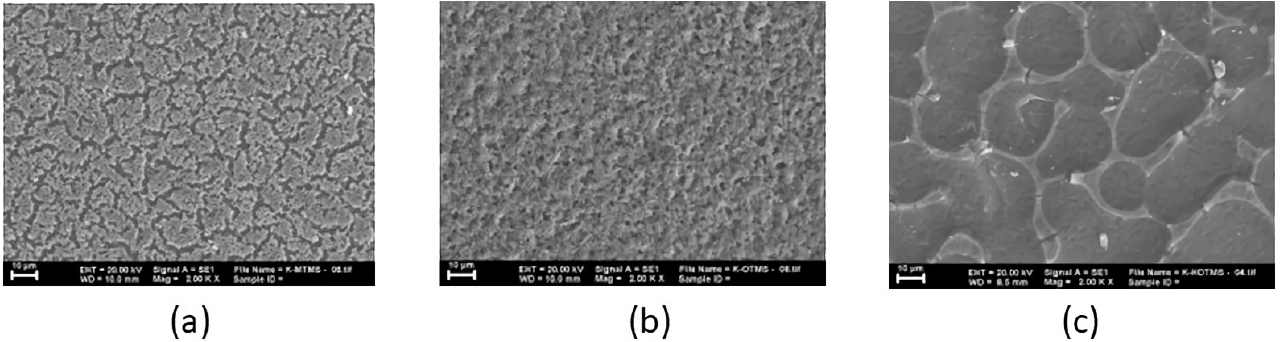
Figure 10. The SEM images of ( a ) SiO 2 -TiO 2 -MTMS, ( b ) SiO 2 -TiO 2 -OTMS, and ( c ) SiO 2 -TiO 2 - HDTMS.